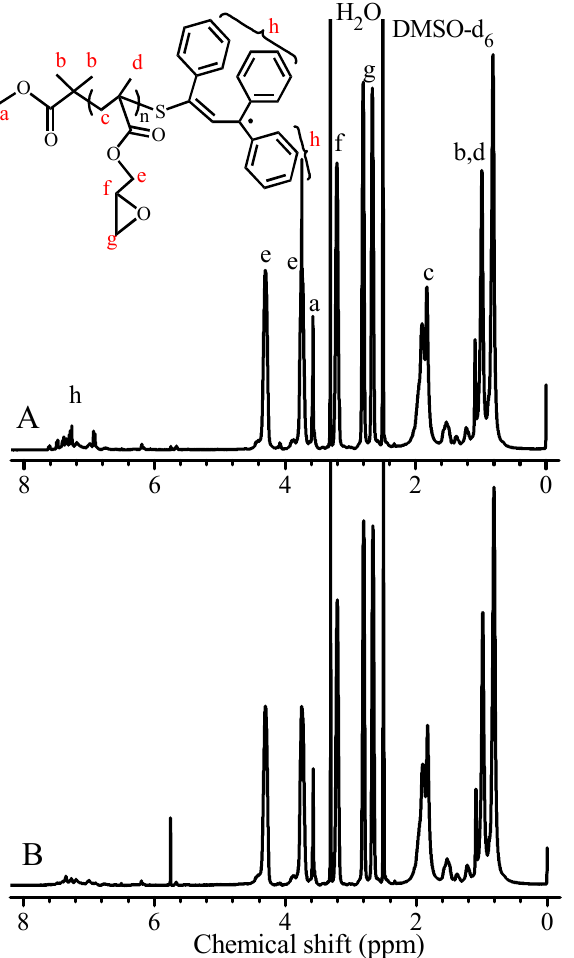
Figure 5. Influence of purification times on the TPPT contents of the obtained PGMA. 1 H NMR spectra of the PGMA respectively obtained after the first ( A ) and the third ( B ) dissolution-methanol precipitation cycle of the PGMA prepared from the polymerization of GMA with the feed molar ratio of GMA/TPPT/AIBME = 10/2/1 at 70 °C for 24 h.